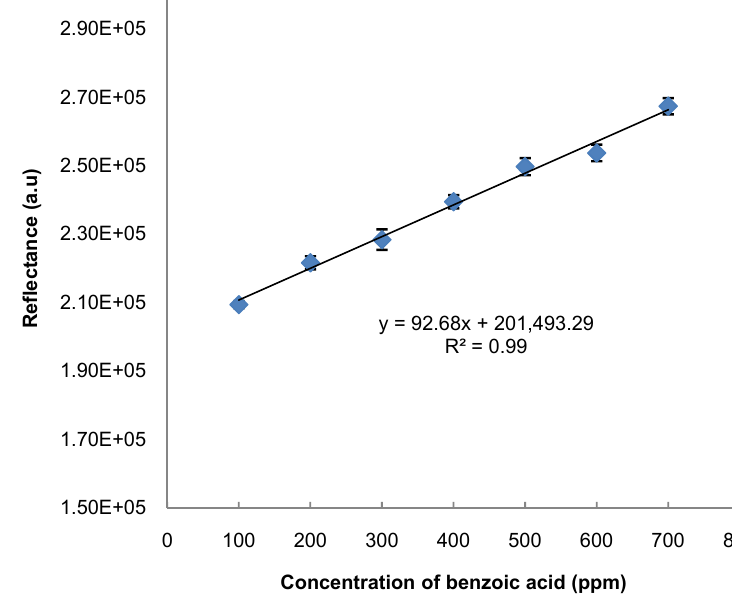
Figure 4. The calibration plot for detection of benzoic acid using the developed test